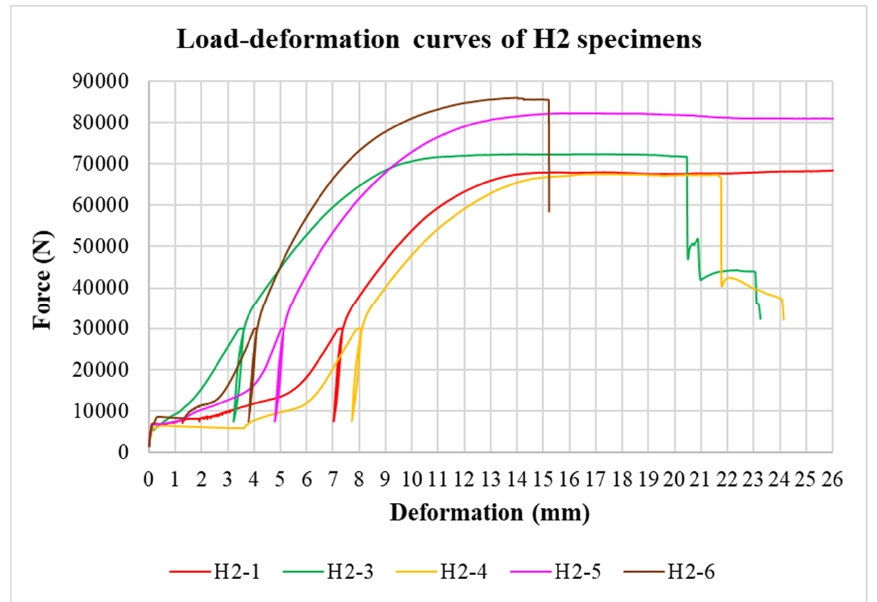
Figure 12. Load-deformation curves of H2 specimens. Table 6. Results of the experimental testing of H2 specimens.